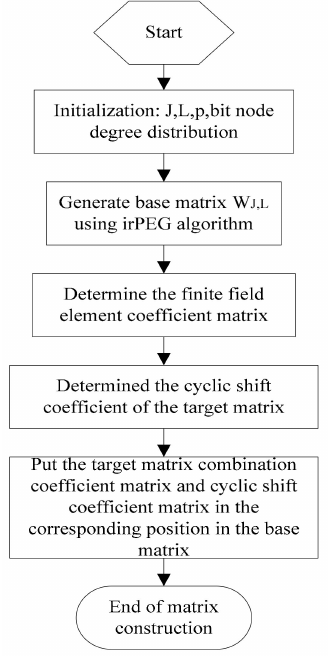
Figure 3. Flow chart of the hybrid check (HC) matrix check